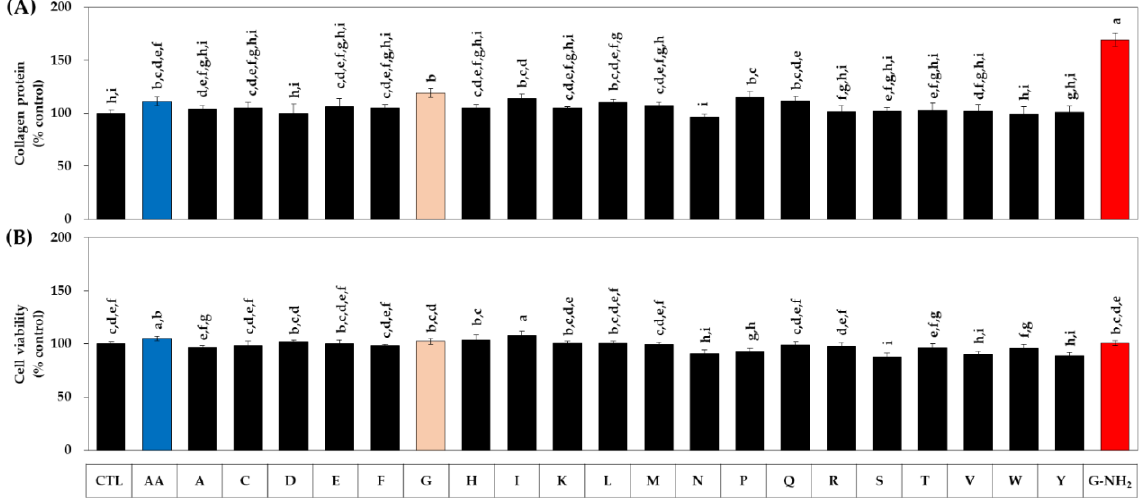
Figure 2. Effects of twenty free amino acids on the collagen production and the viability of HDFs. AA was used as a positive control. Cells were treated with vehicle (CTL), AA, or each amino acid at 1 mM. After 48 h, the collagen protein secreted into the conditioned medium was quantitated ( A ). The viability of the adherent cells was determined ( B ). Data are presented as % of control (means ± SD, n = 3 for ( A ), and n = 4 for ( B )). Groups that share the same alphabet letters (a – i) do not have significantly different means at the p < 0.05 level.